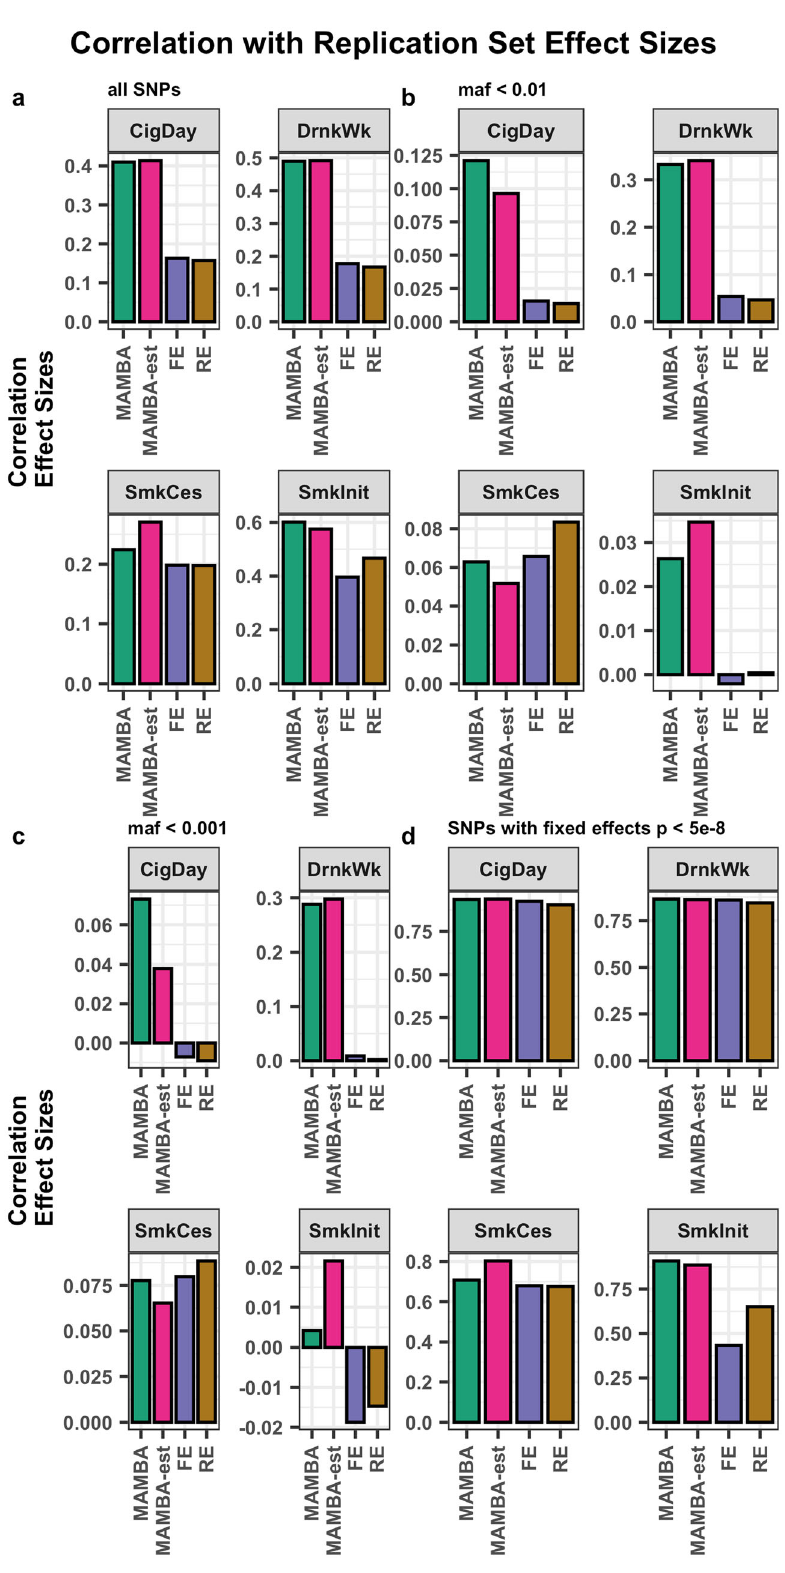
Fig. 5 Pearson Correlation of meta-analysis estimated effect sizes with replication cohort effect sizes. We separately considered the correlation for ( a ) all variants ( b ) low-frequency variants (MAF < 0.01) ( c ) rare variants (MAF < 0.001) ( d ) genome-wide signi fi cant SNPs (two-sided unadjusted p -value < 5 × 10 − 8 ). Source data are provided as a Source Data fi